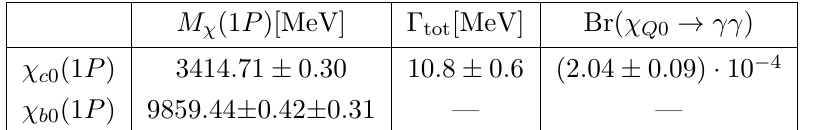
Figure 2 . Light cone wave function